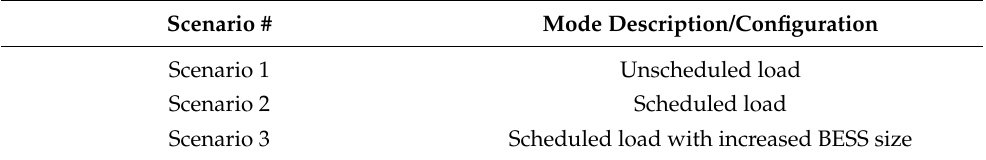
Table 7. Illustration of scenario and